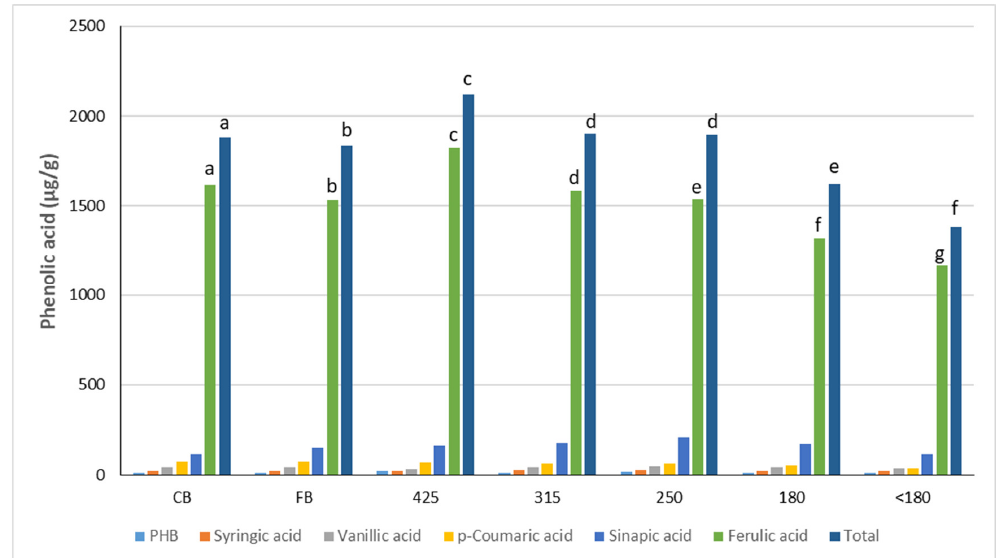
Figure 4. Phenolic acid content (µg/g dm) of bran fractions. Bars with alike letters in matching colours are not significantly different, p < 0.001. PHB = p -hydroxybenzoic acid. CB; coarse bran. FB; fine bran.